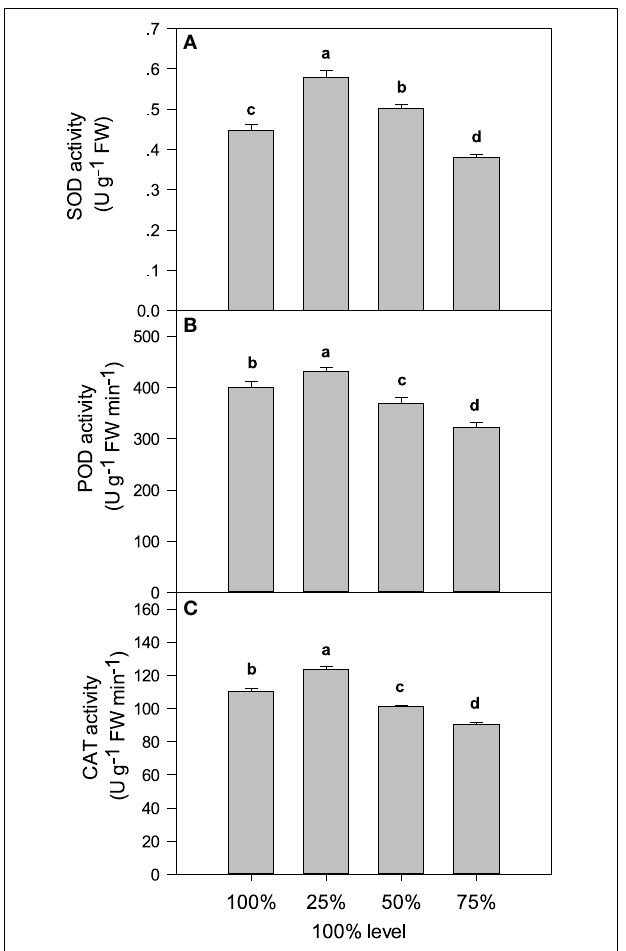
FIGURE 5 | Light intensity and (A) SOD, (B) POD, and (C) and CAT activity in C. acuminata leaves. The values presented are the means ± SE . Different letters indicate significant differences between irradiance treatments ( P < 0 . 05 ); n = 5 . 100% level = 1500 ± 30 µ mol m − 2 s − 1 .